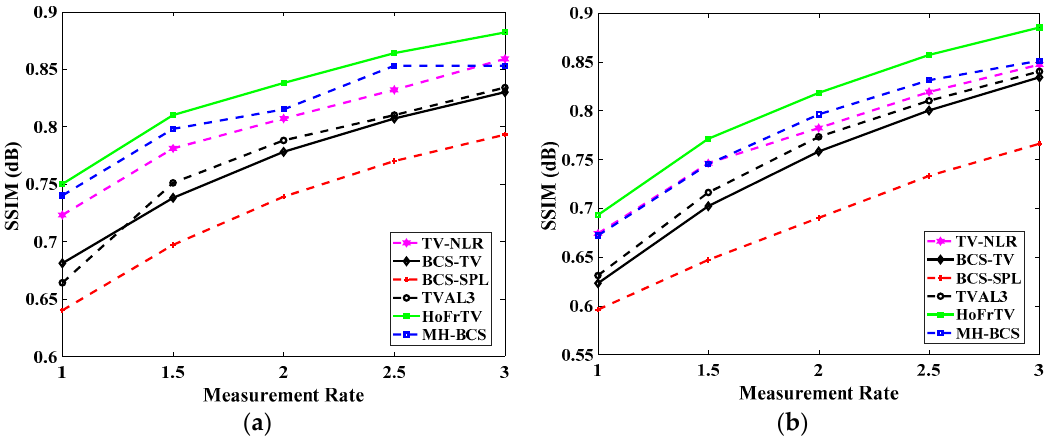
Figure 6. The SSIM curves of two images: ( a ) Barbara and ( b ) Boats.